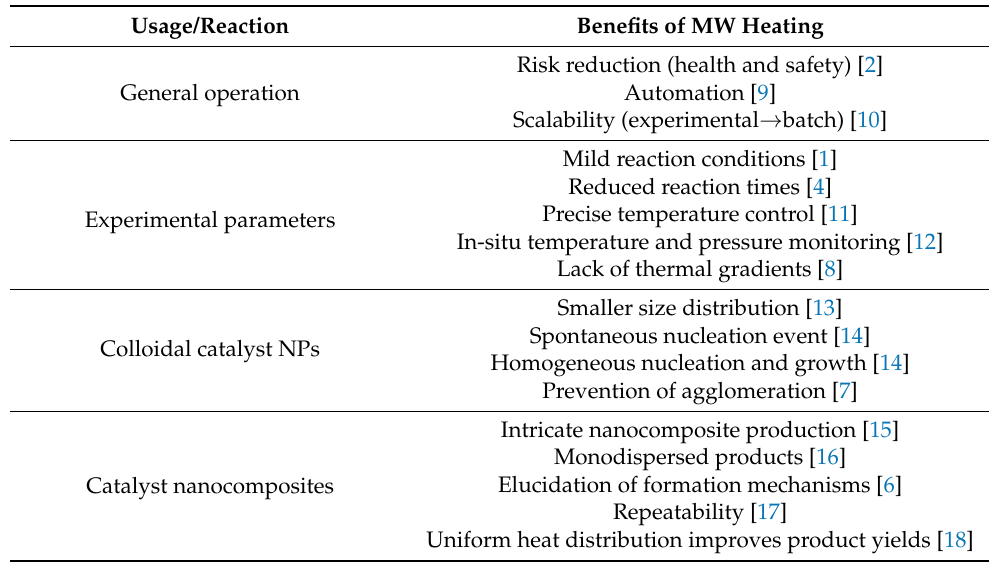
Table 1. Advantages of MW irradiation over conventional heating